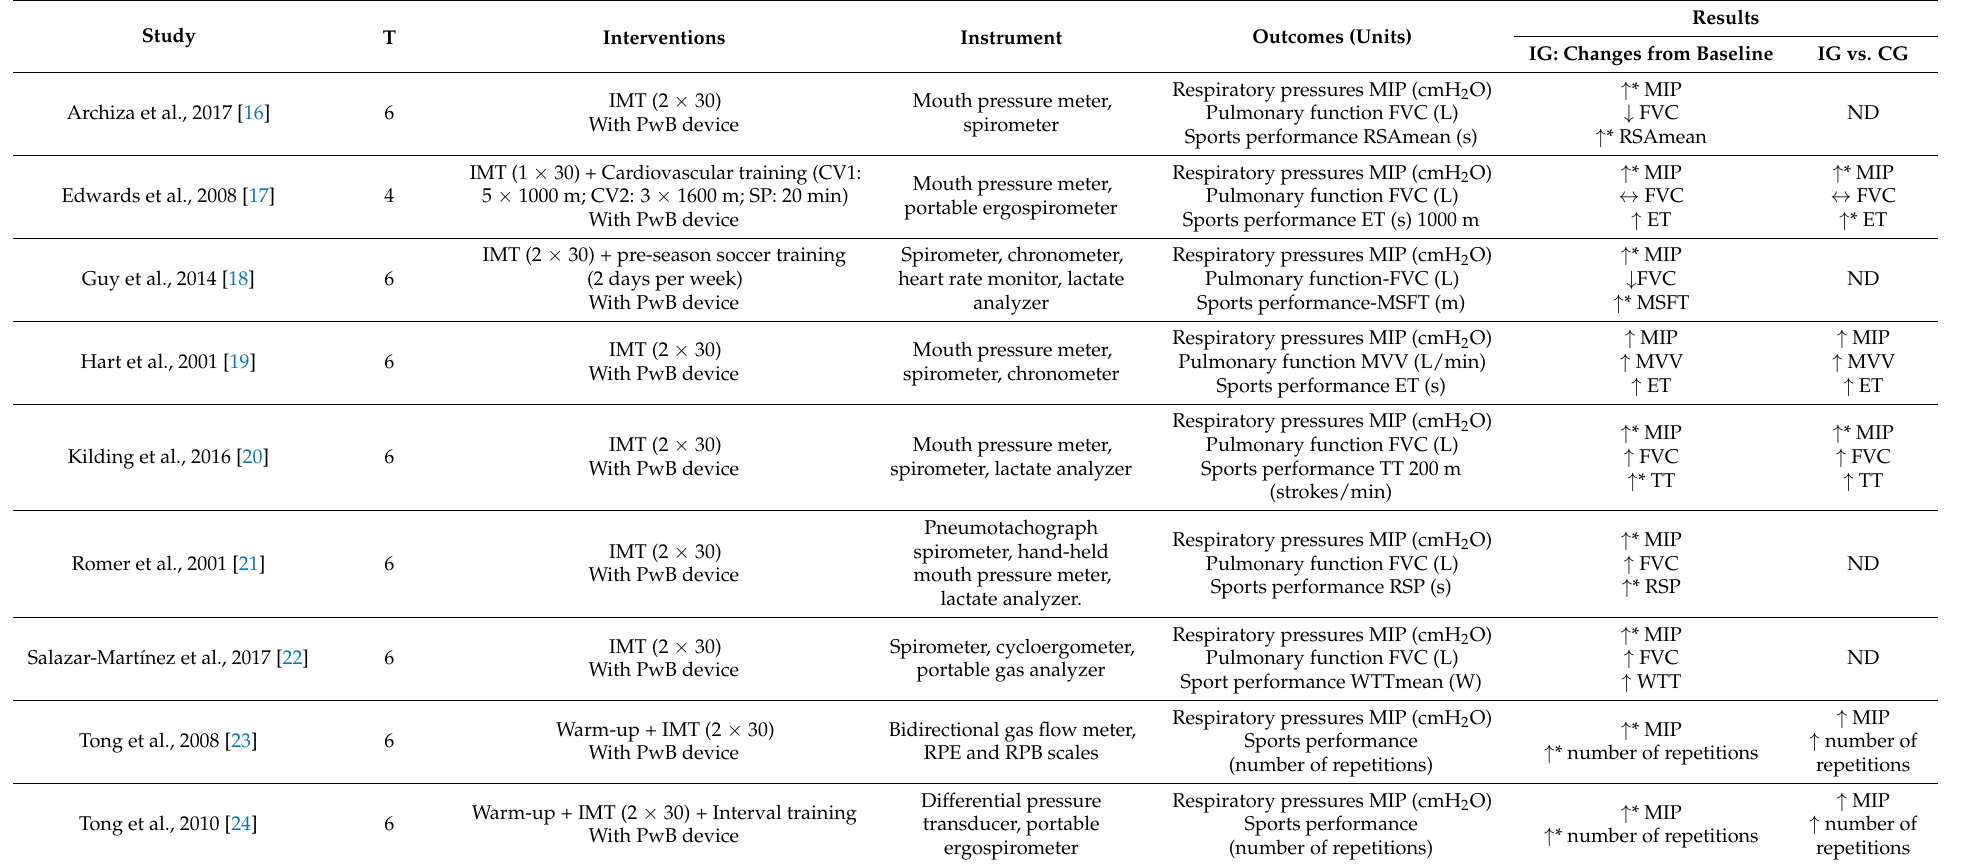
Table 2. Studies included in the systematic review of the effect of PowerBreath ® in physically active, healthy